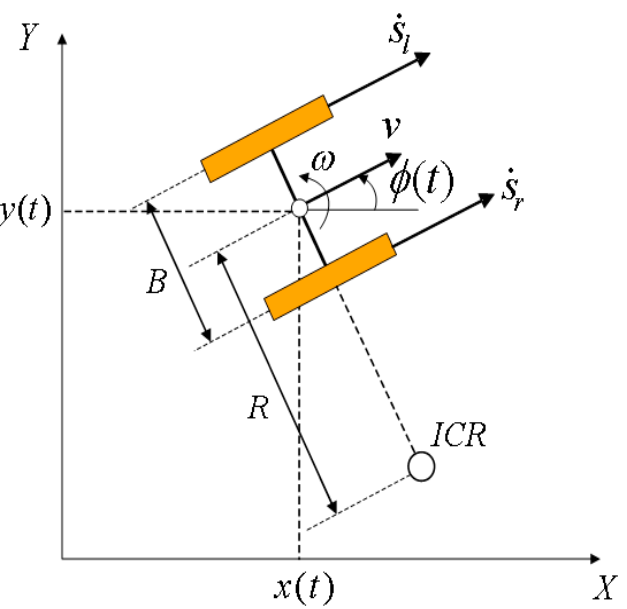
. . s l , s r : linear velocity of the left and right wheels, s s   : linear velocity of the left and right wheels, l r